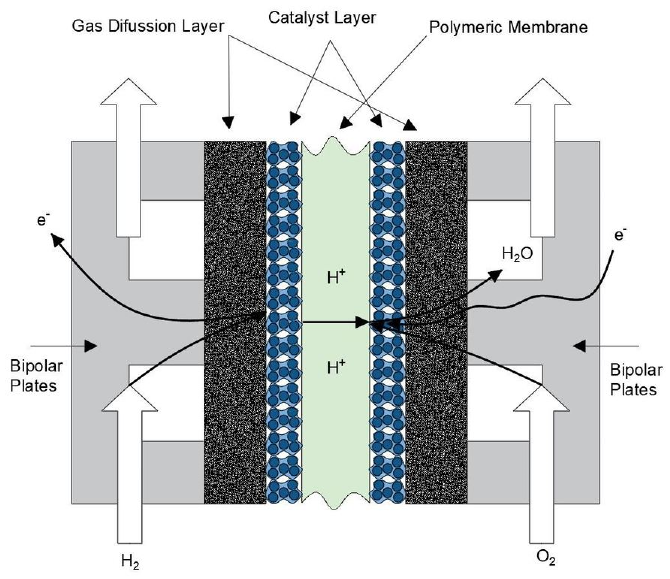
Figure 1. Representative internal scheme of a Polymer Electrolyte Fuel Cell (PEFC)